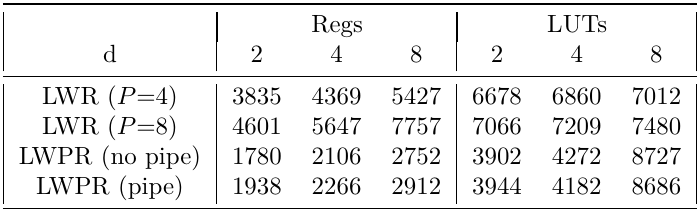
Table 1: Implementation cost of the re-keying functions. Regs